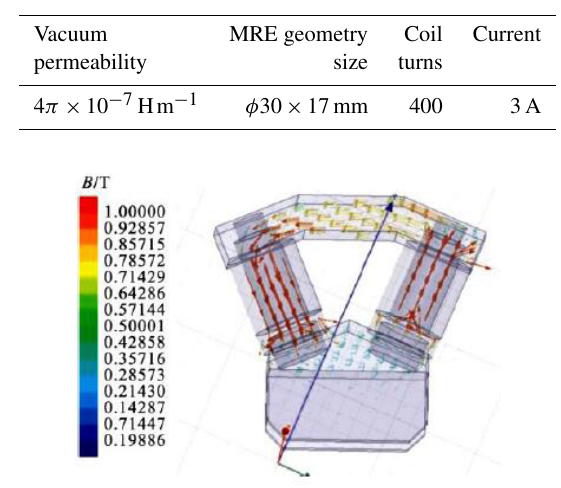
Table 4. Magnetic circuit simulation parameters.